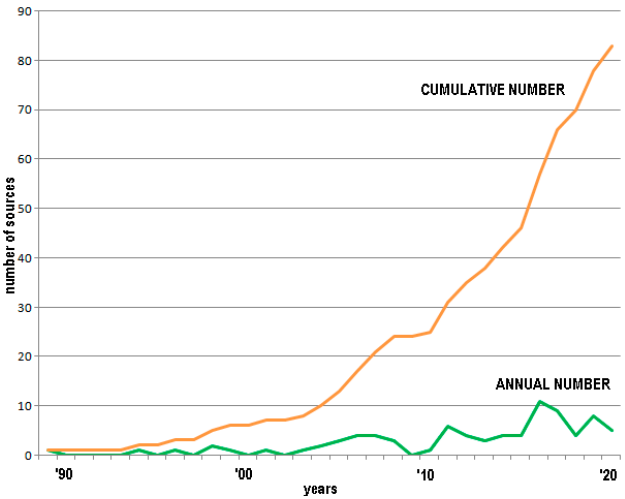
Figure 2. Distribution of the studies under review by year of publication. See Table 1 for data. The first three months were considered for 2020.